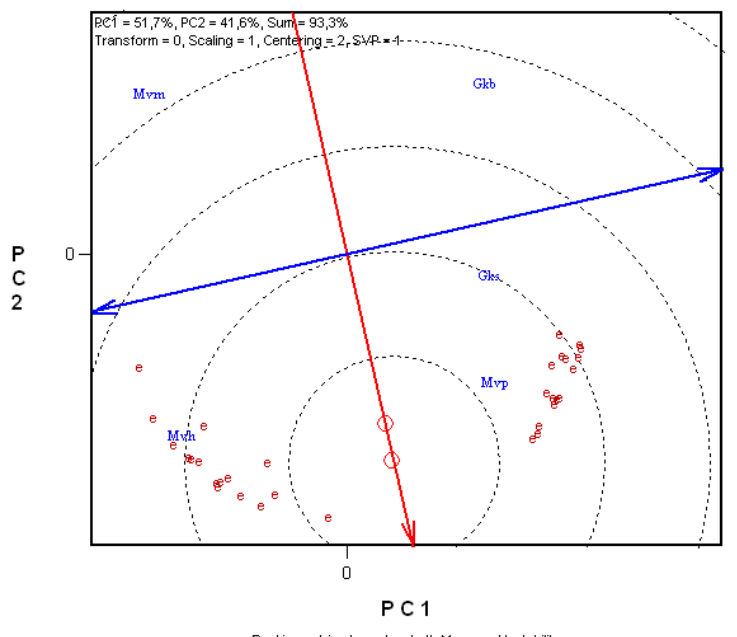
Figure 4. Comparison between the genotypes tested and the ideal genotype on the basis of gluten index (right sector) and Minolta b* values (left sector) over 16 years. Environment-centred (Centering = 2) GGE biplot analysis based on non-scaled data (Scaling = 0) with environment-metric (SVP = 2) plotting. E05–E20: years 2005–2020; ‘Gkb’, ‘Gks’, ‘Mvm’, ‘Mvp’, ‘Mvh’: genotypes; PC1, PC2: principal component variables; the average environment axis (AEA) is represented by a thick red line; the stability axis is plotted with thick blue line; O: year mean; O in the middle of the concentric circles: ideal